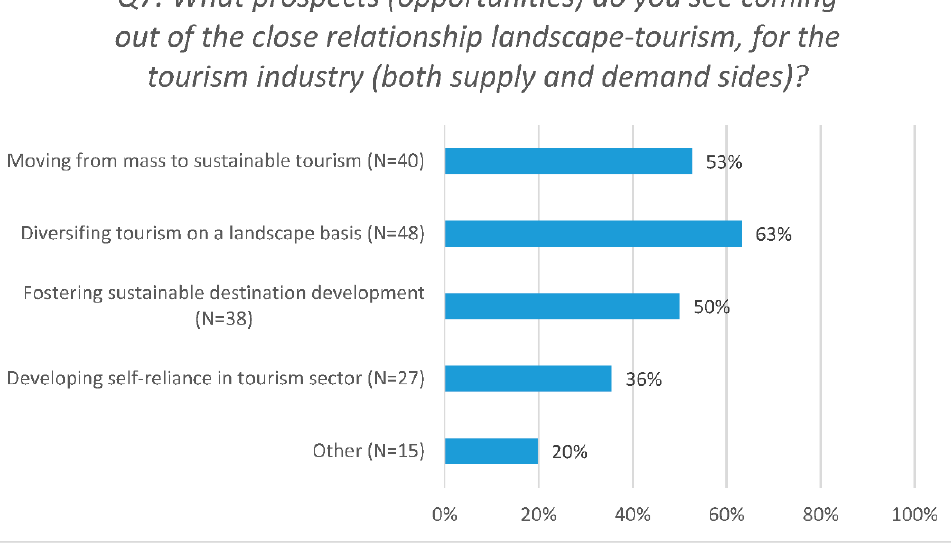
Figure 5. Prospects of the tourism–landscape relationship for the tourism industry.